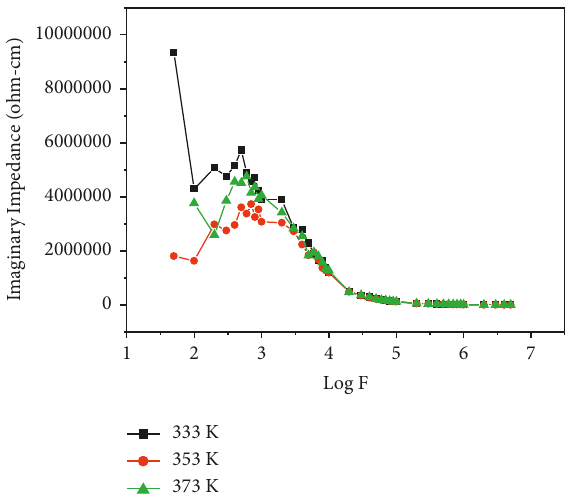
Figure 8: Imaginary impedance vs log F.